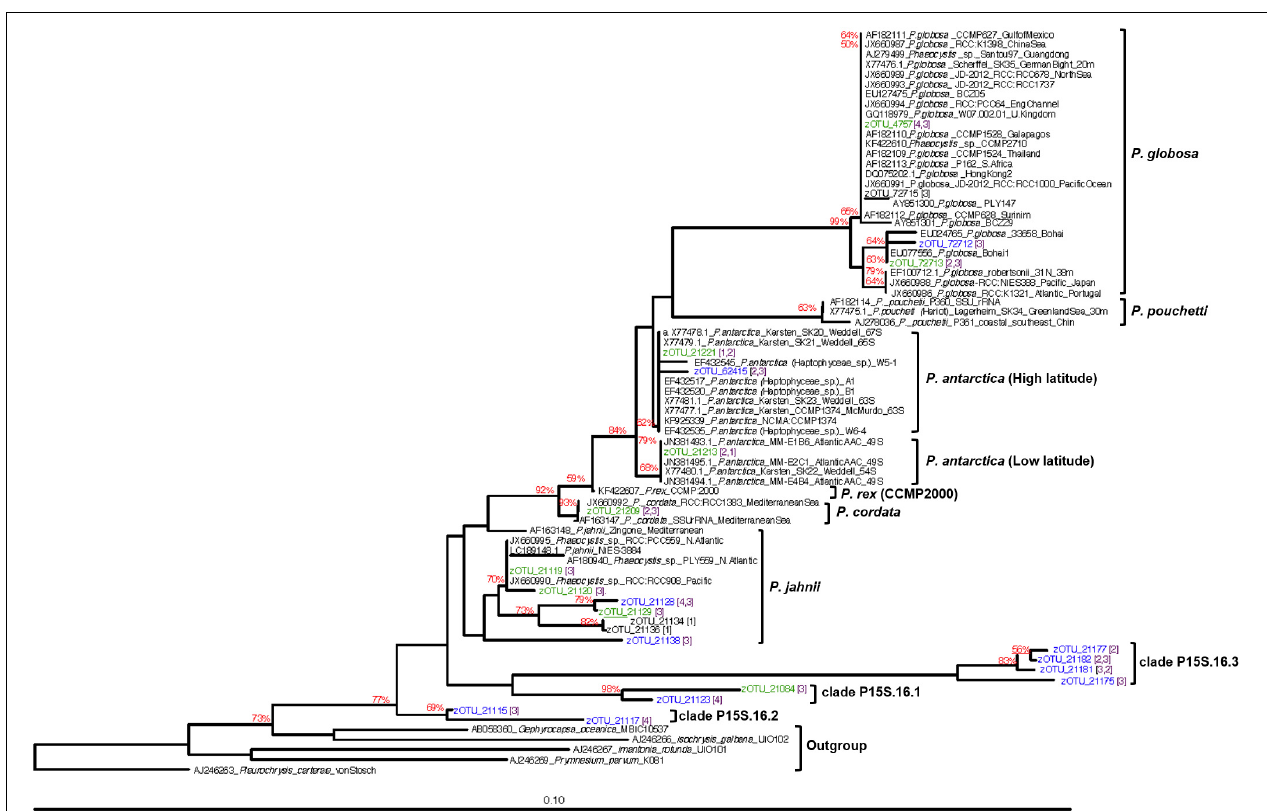
FIGURE 5 | Neighbor-joining tree of abundant Phaeocystis zOTUs clustered against other known Phaeocystis 18S rRNA gene sequences. Sequences in green are high-abundance ( > 1% relative abundance) zOTUs, while sequences in blue are mid-abundance (0.1–0.99% relative abundance) zOTUs from this study. Bootstrap values above 50% are indicated at the branches in red. To more easily identify the regions where our Phaeocystis zOTUs originated from, we established the following four categories of regions – (1) Antarctic (65–55 ◦ S); (2) subantarctic (55–45 ◦ S); (3) mid-latitudes (45–15 ◦ S); (4) low-latitudes (15 ◦ S–0 ◦ ). Numbers in purple and square parenthesis indicate the region the zOTU was detected. Where more than one number is indicated, the first number indicates the region where higher abundances of that zOTU was